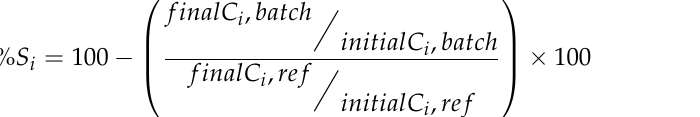
in Table S1) in batches performed with crushed materials, a S:W ratio of 1:3, and a